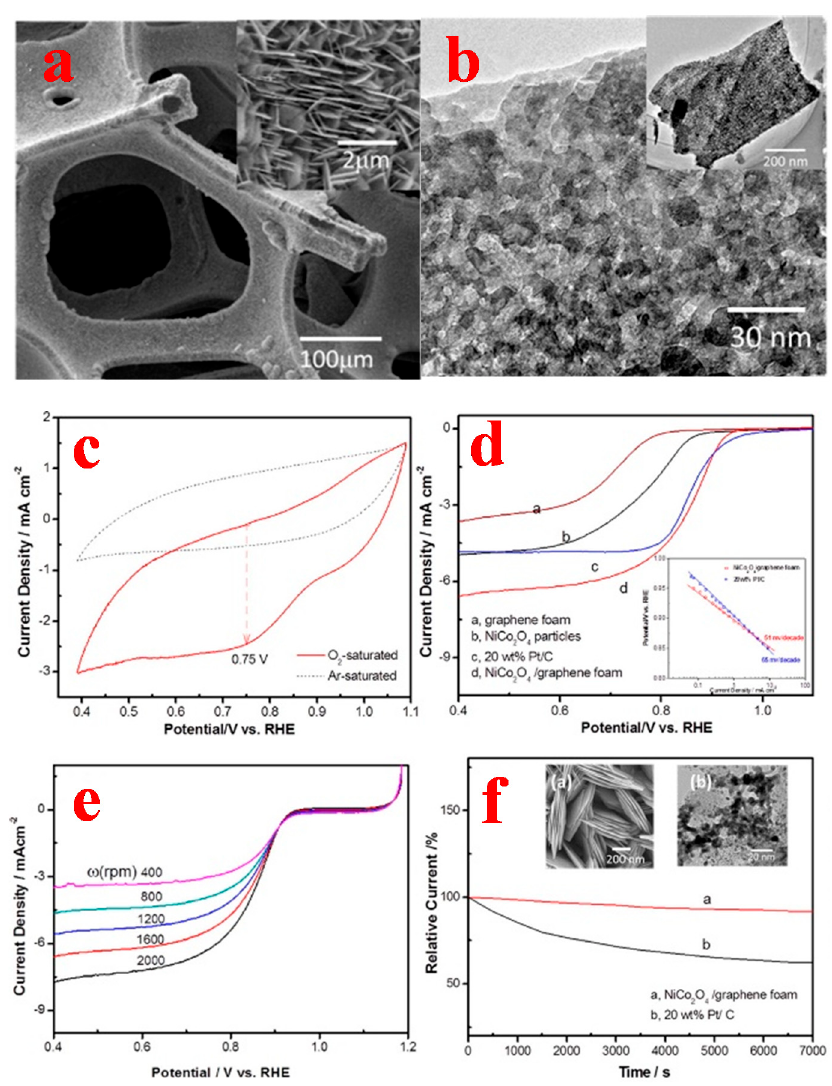
Figure 10. ( a ) SEM images of NiCo 2 O 4 /3D ‐ graphene; the inset shows that the as ‐ prepared NPs grow vertically on the surface of 3D ‐ G; ( b ) TEM image of NiCo 2 O 4 /3D ‐ G; the inset is the TEM image with low magnification; ( c ) CV curves of NiCo 2 O 4 /3D ‐ G in O 2 ‐ and Ar ‐ saturated 0.1 M KOH solution; ( d ) LSV curves of different electrocatalysts (1600 rpm); (e) LSV curves of NiCo 2 O 4 /3D ‐ G at different rotation rates at a scan rate of 10 mV ∙ s − 1 ; ( f ) the stability test for NiCo 2 O 4 /3D ‐ G and Pt/C (20%), measured by the current at 0.75 V vs. RHE; the insets are the SEM image of the (a) NiCo 2 O 4 /3D ‐ G and (b) Pt/C after the test. Reprinted with permission from [126]. Copyright 2016, American Chemical Society.